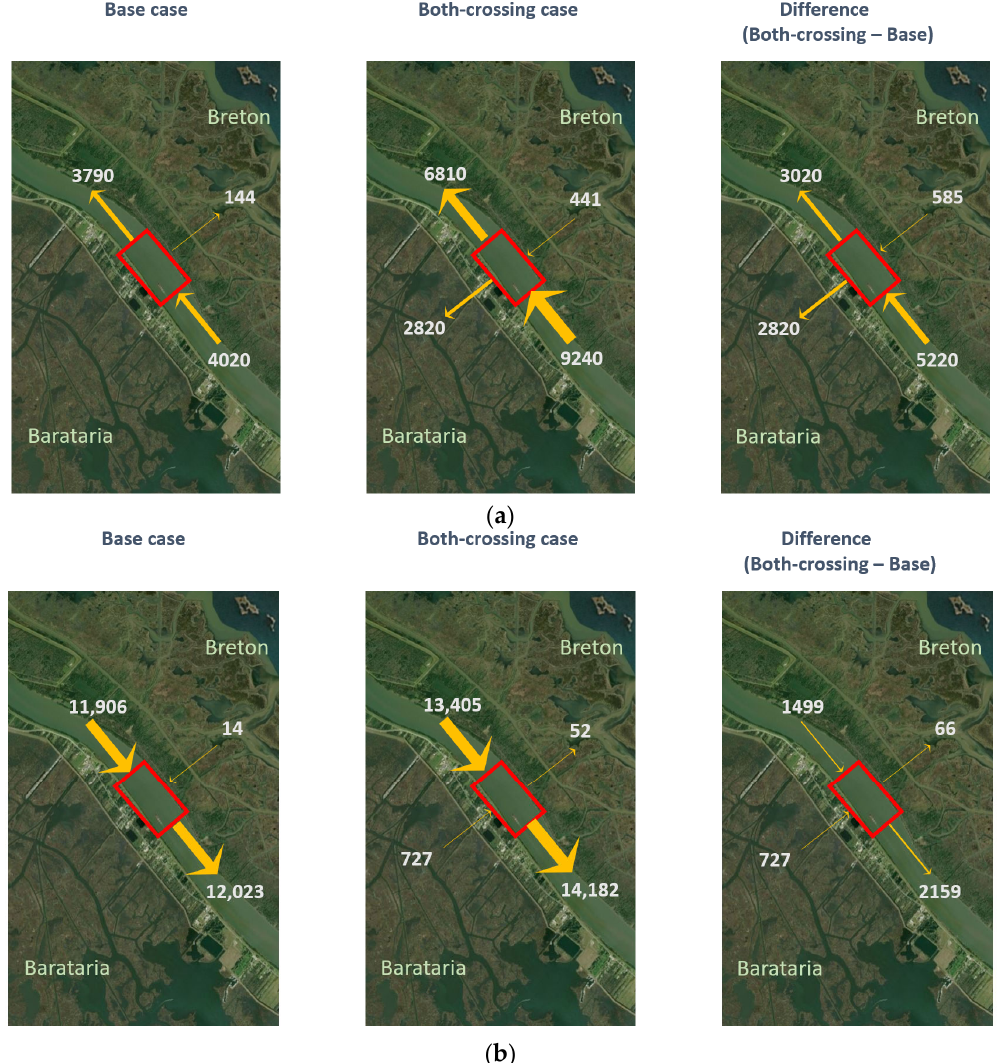
Figure 11. Flux (m 3 /s) analysis at the lower ‐ crossing location for 02:45 UTC 8/29/2012 (top) and 16:45 UTC 8/29/2012 (bottom) during Isaac (2012). The thickness of flux arrow is proportional to the amount. ( a ) 02:45 UTC 29 August 2012. ( b ) 16:45 UTC 29 August 2012.